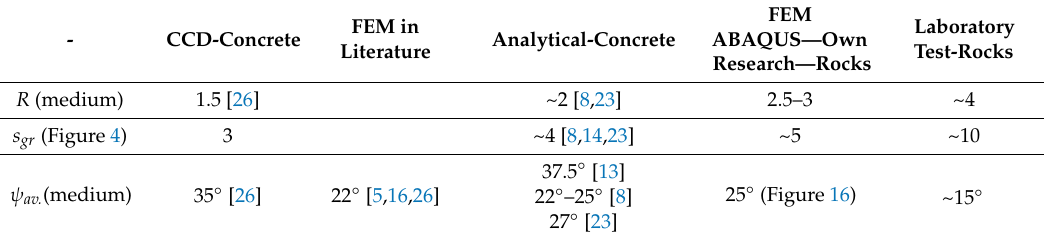
Figure 16. The average breakout cone angle ψ av (simulations, Figure 7). Table 2. Comparison of the values of the tested parameters R and ψ